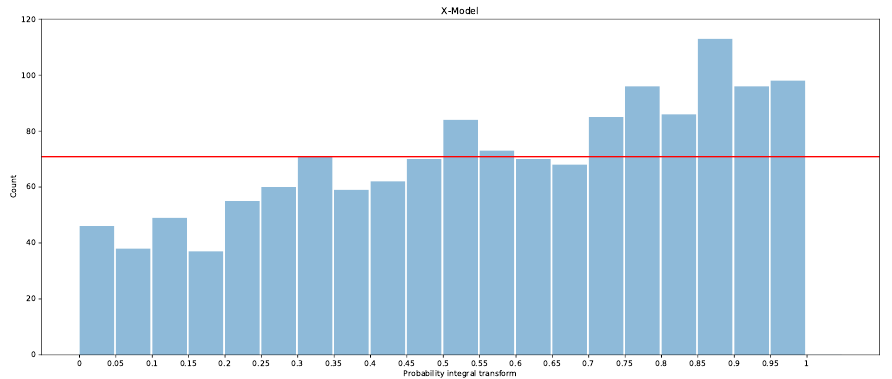
Figure 21. PIT for the X-model for the first two months of the test